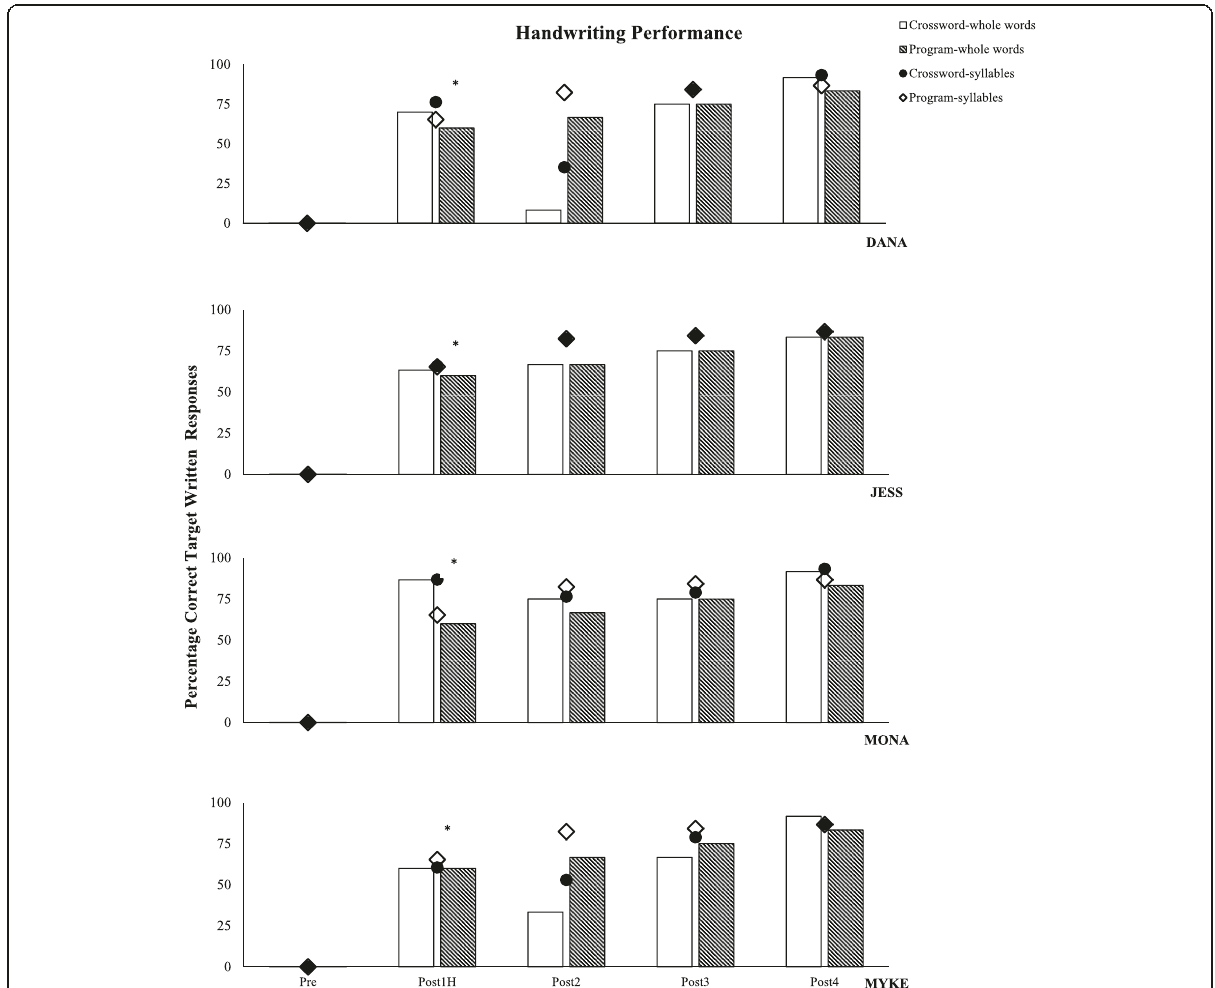
Fig. 4 Percentage of correct whole-word and syllable handwriting in the program handwriting posttest and whole-word and syllable writing responses during crossword games. * The crossword data represents the average of correct responses in the horizontal and the vertical crosswords that were used after Unit